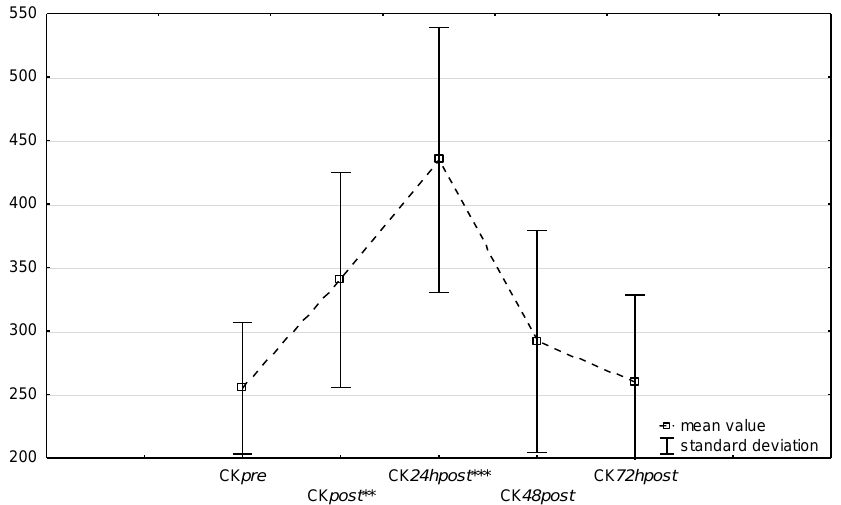
Figure 11. Creatine kinase concentrations before and after the match and in the course of post-exercise regeneration with the use of partial body cryostimulation. ** significant difference vs. CKpre at p < 0.01; *** significant difference vs. CKpre at p < 0.001